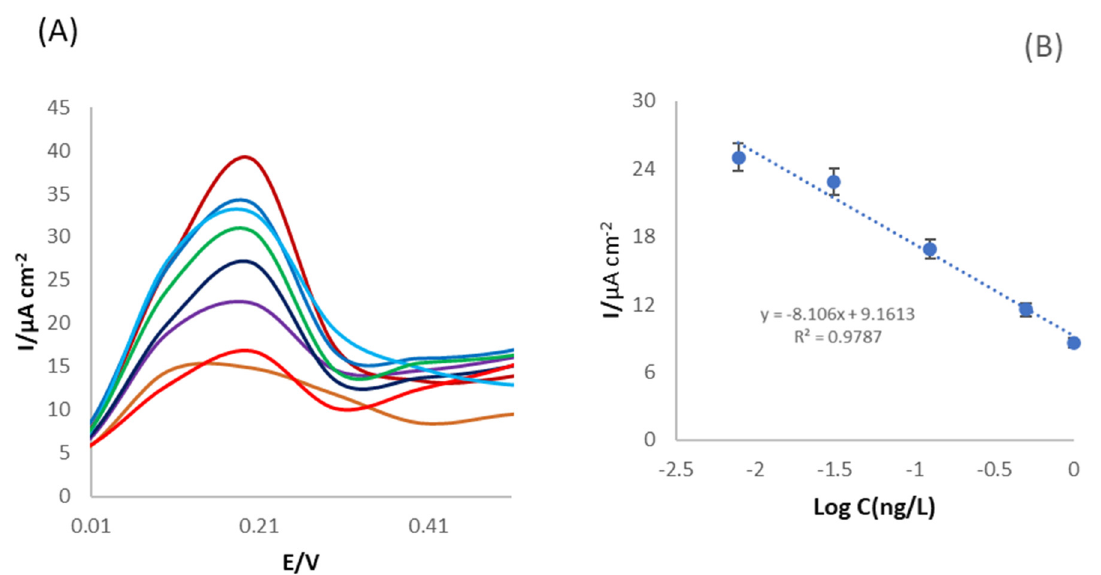
Figure 3. ( A ) DPV graphs of the engineered immunosensor at different concentrations of 2-AG (1, 0.25, 0.0625, 0.5, 0.125, 0.0312, 0.0078, and 0.00195 ng/L). The measurement conditions were similar to those shown as the legend of Figure 2. ( B ) Calibration curve (n = 3; SD = 1.77).